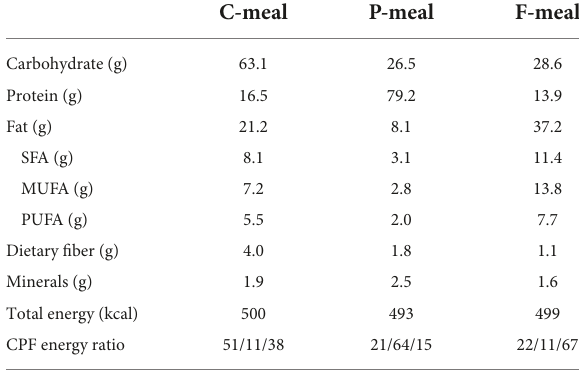
TABLE 1 Nutrient composition of the test